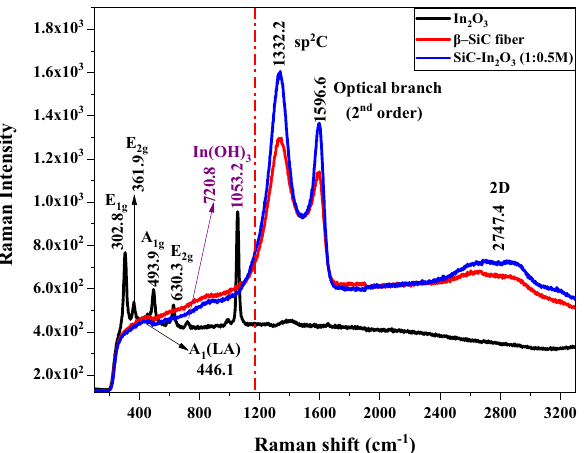
Figure 4. Raman spectra of In 2 O 3 , pure β-SiC fiber and β-SiC-In 2 O 3 nanocomposite (thermal annealing at 400